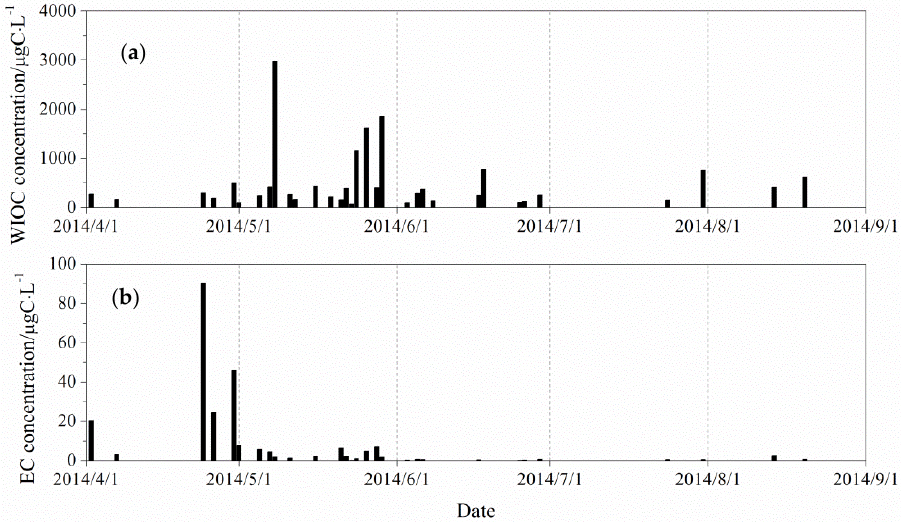
Figure 4. WIOC ( a ) and EC ( b ) concentrations in precipitation in Xiamen Island during the study period.